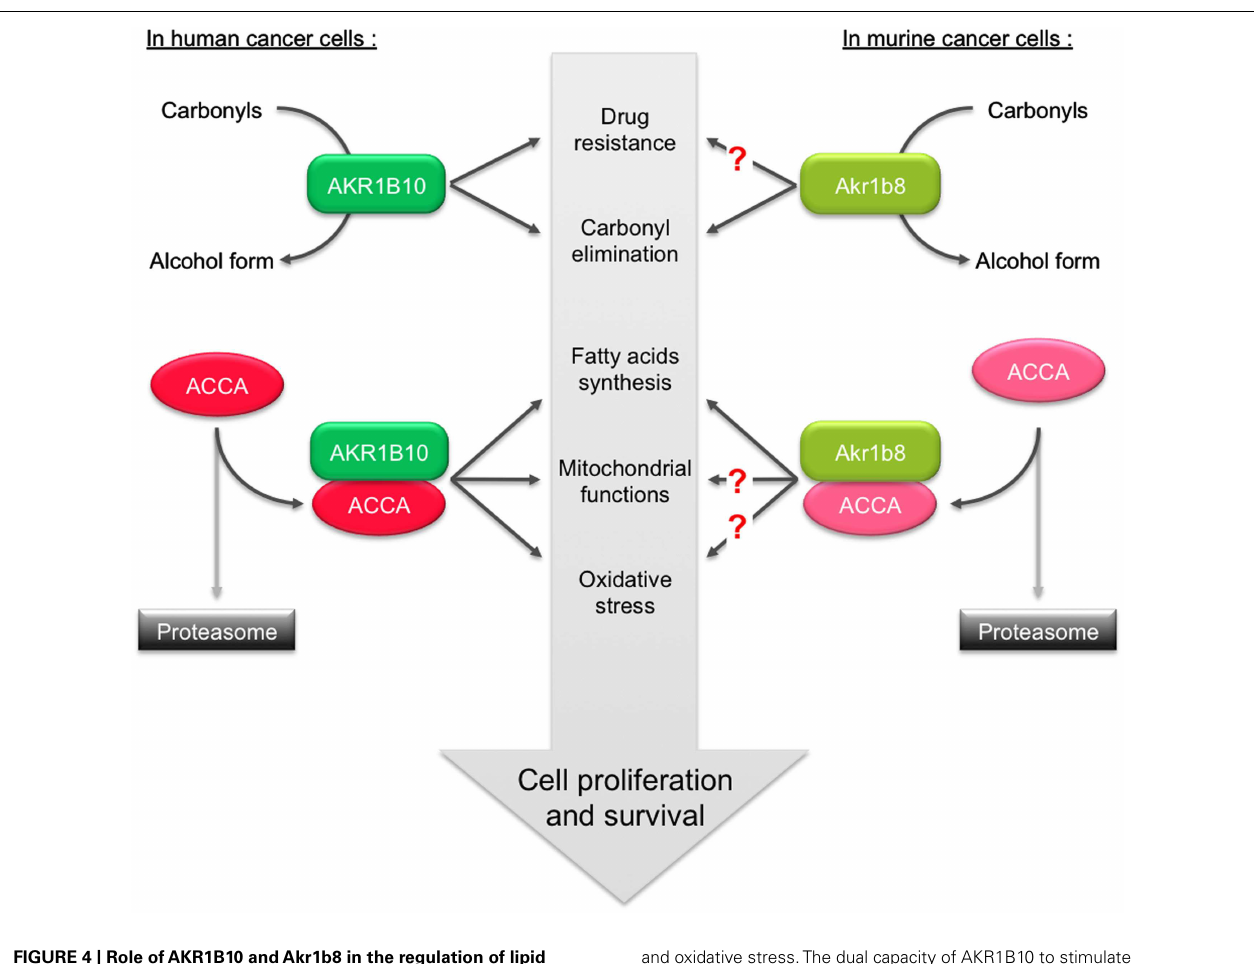
FIGURE 4 | Role ofAKR1B10 andAkr1b8 in the regulation of lipid synthesis and contribution in promoting cancer. In human cancer cells, ACCA is protected against ubiquitination-proteasome dependent degradation through its association with AKR1B10. Stabilization of ACCA increases fatty acids synthesis.This protects cell from apoptosis by preventing depletion of phospholipids, mitochondrial membrane lesions,